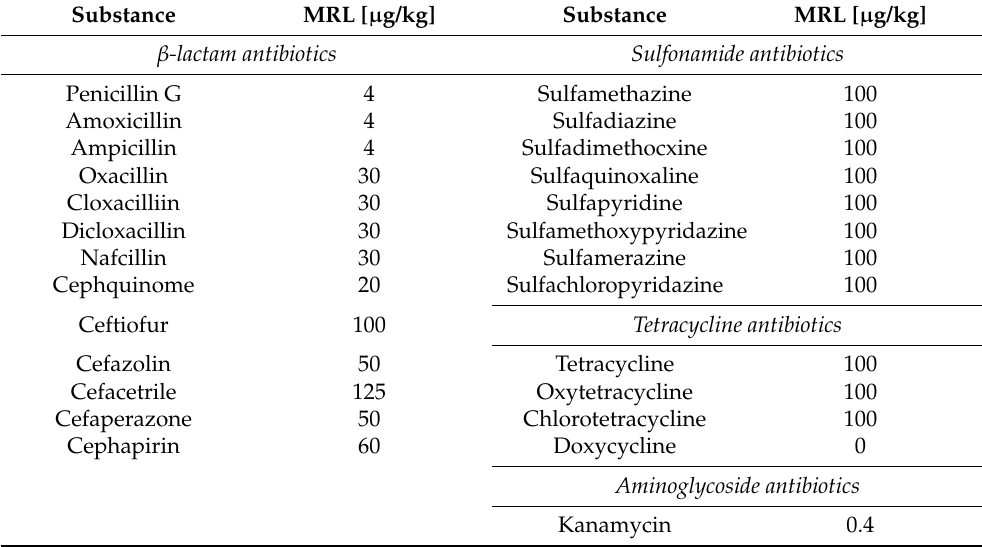
Table 1. The maximum residue limit (MRL) for selected antibiotics in cow’s milk [13,14]. Substance MRL [ µ g/kg] Substance MRL [ µ